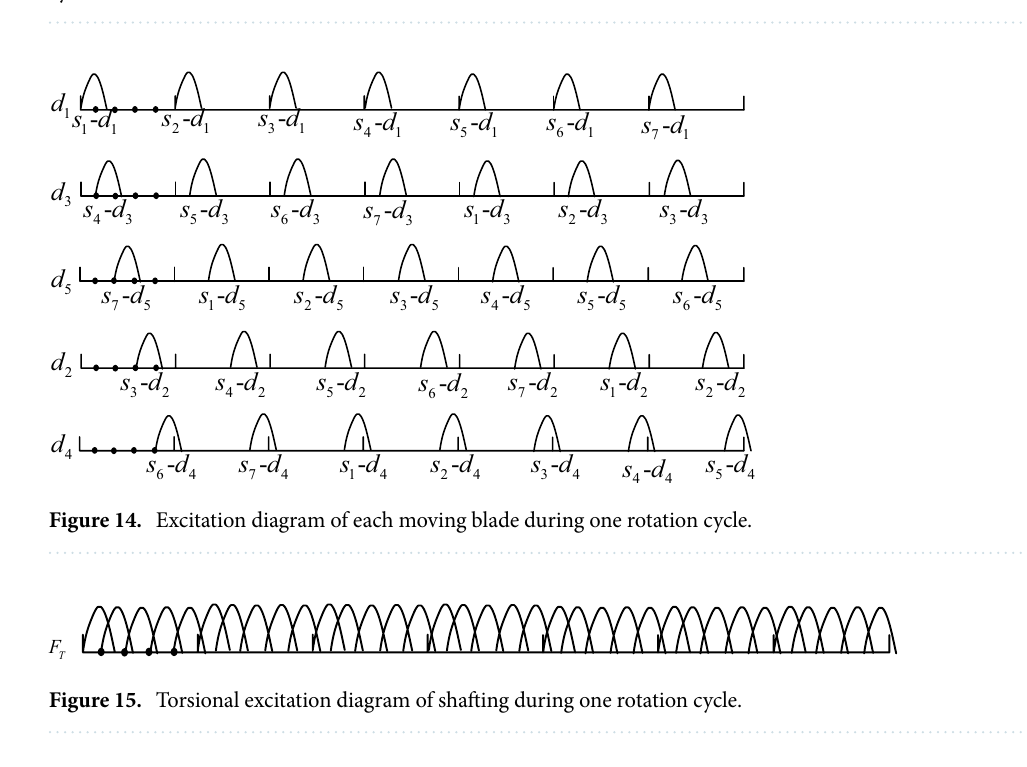
Figure 15. Torsional excitation diagram of shafting during one rotation